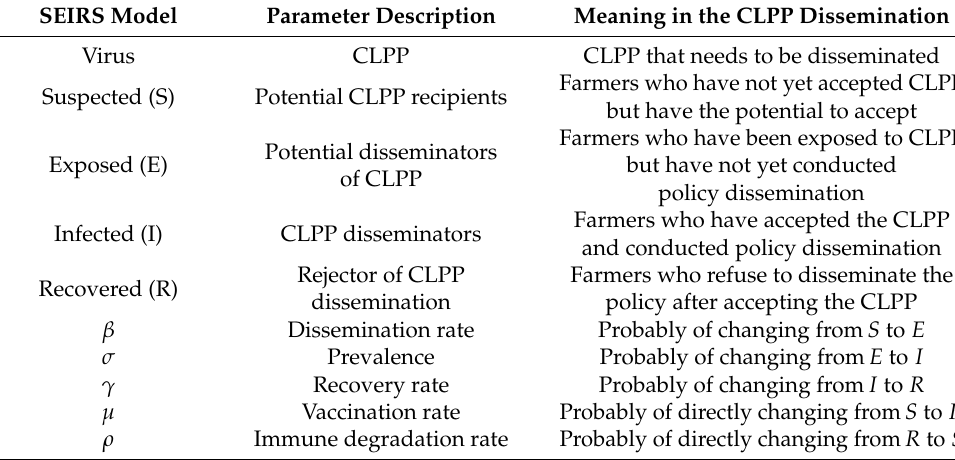
Table 1. Concept